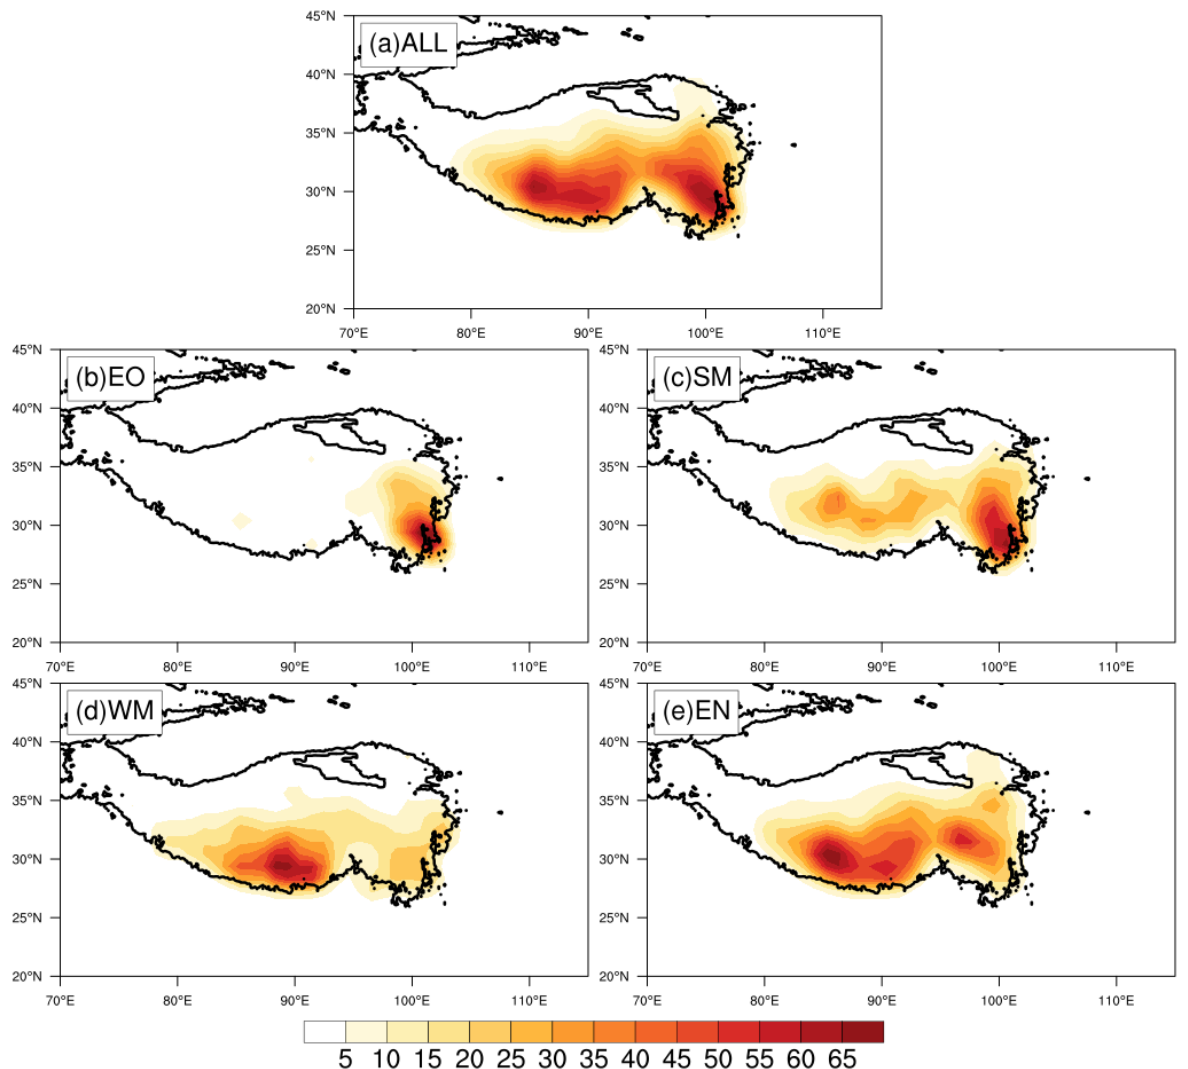
Figure 5. Spatial distribution of MCS initiation over the TP on 1° × 1° grids. ( a ) All MCSs; ( b ) EOs; ( c ) SMs; ( d ) WMs; ( e ) ENs.